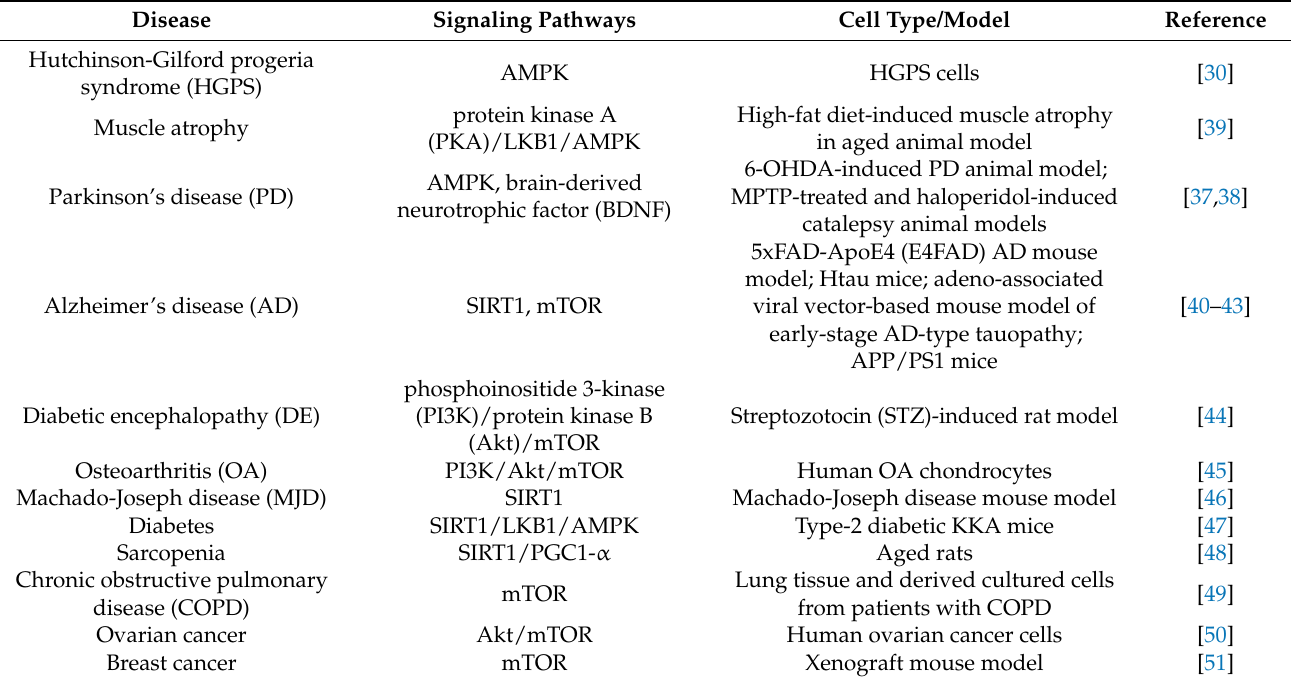
Table 1. Age-related diseases and their currently identified signaling